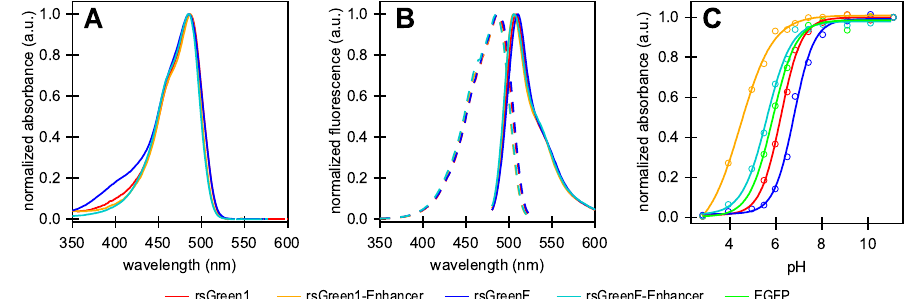
Figure 1. Absorption, excitation and emission spectra of rsGreens and Enhancer constructs. ( A ) Normalized absorbance spectra; ( B ) excitation (dashes) and emission (solid) spectra; ( C ) pH titration curves showing the absorption maximum at different pH values of the indicated labels. All graphs were normalized to their maximum absorption, excitation or emission. EGFP: enhanced green fluorescent protein; a.u.: arbitrary units. Table 1. Spectroscopic properties of enhanced green fluorescent protein (EGFP), rsGreens and Enhancer constructs. From top to bottom: peak excitation wavelength ( λ ex ), peak emission wavelength ( λ em ), p K a , quantum yield of fluorescence ( Φ FL ), apparent extinction coefficient ( ε 7.4 ) (at λ ex , pH 7.4)